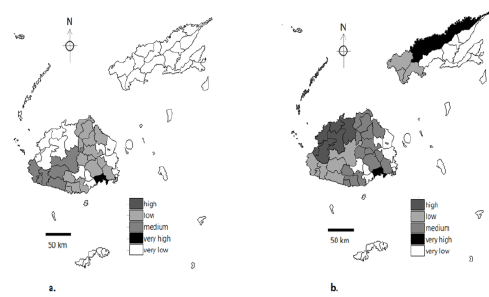
Figure 12a . LUI of farms of 20-50 size. Figure 12b. LUI of farms of 50-100ha size.